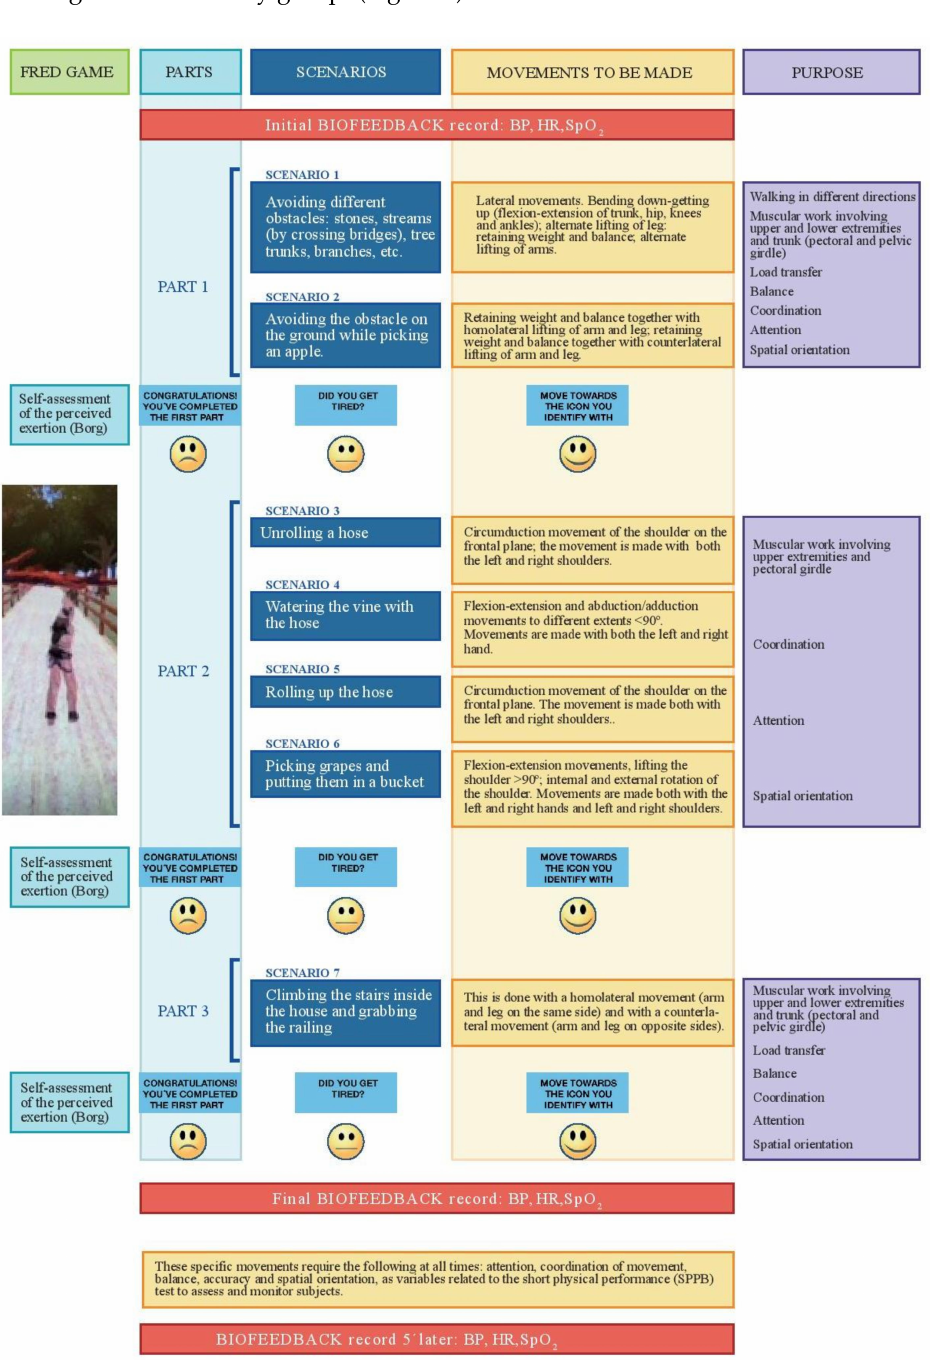
Figure 2. FRED game overview: structure and